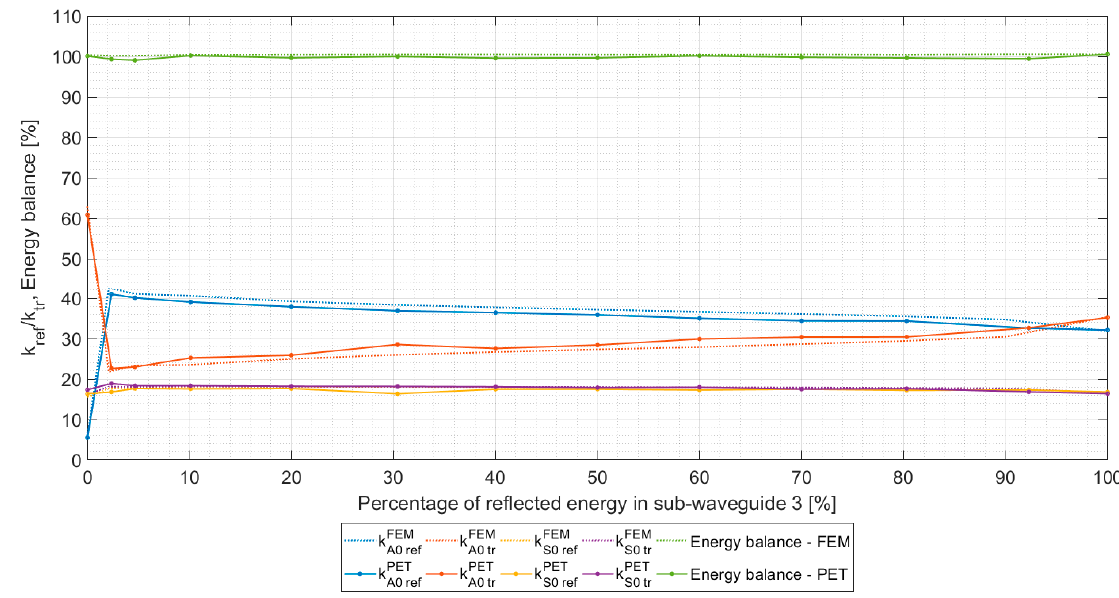
Figure 6. Energy scattering coefficients in the main waveguide section versus percentage of reflected energy prescribed in sub-waveguide 3.